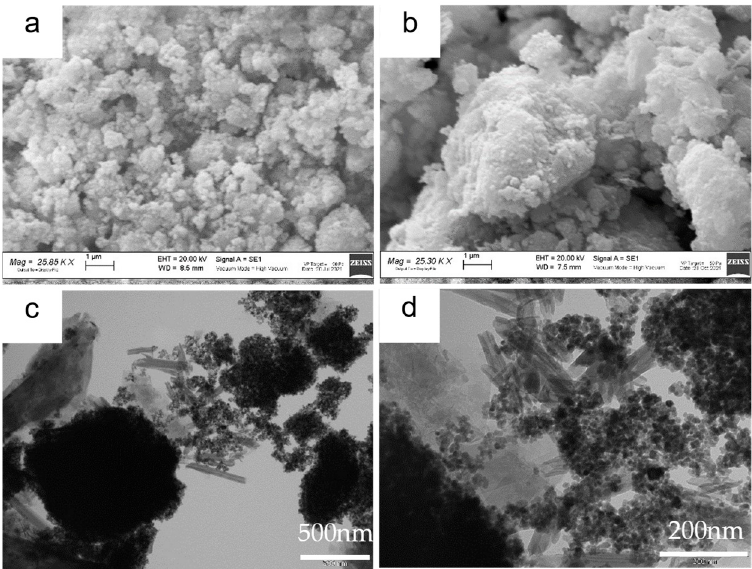
Figure 3. ZnS–GO powder: ( a ) and ( b ) SEM images at 25 kX, ( c ) and ( d ) TEM images at 50 kX and 150 kX, respectively.